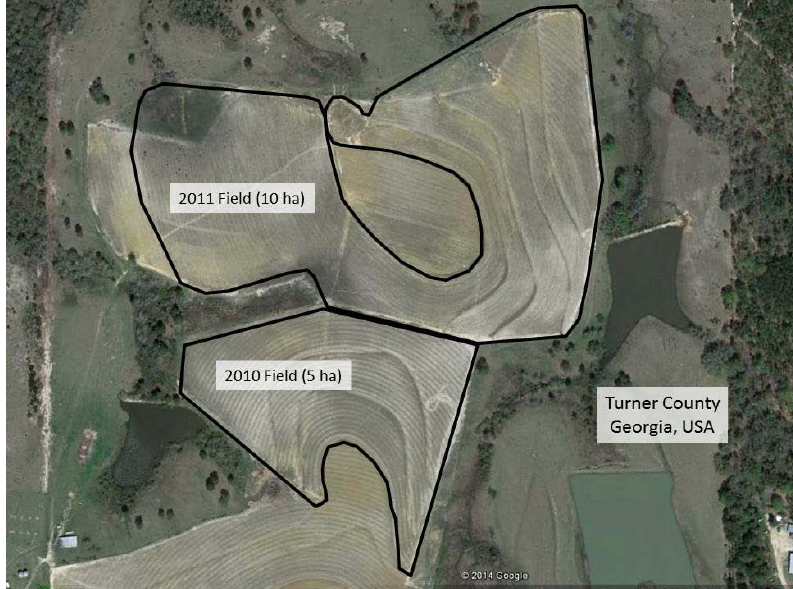
Figure 1. Google Earth image of the two fields used in the study. The field used in 2011 was expanded to the black boundaries shown in the figure to accommodate a new center pivot irrigation system. The tear drop-shaped area in the middle of the field was not used for the study. Non-parallel earthen terraces used to control erosion are clearly seen in both